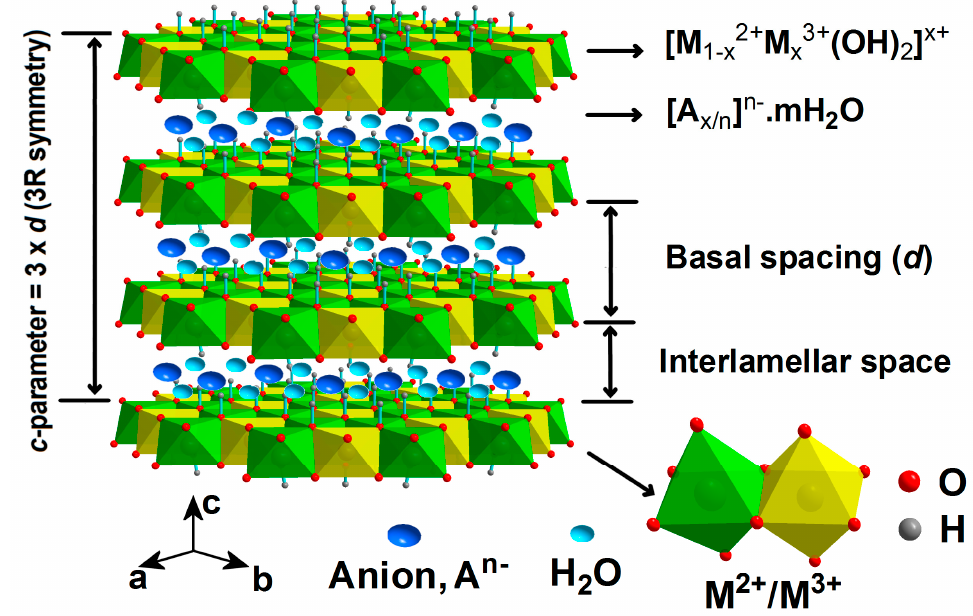
Figure 1. Schematic representation of the classical LDHs structure. Adapted from Ref. [11], Copyright 1999, Elsevier.